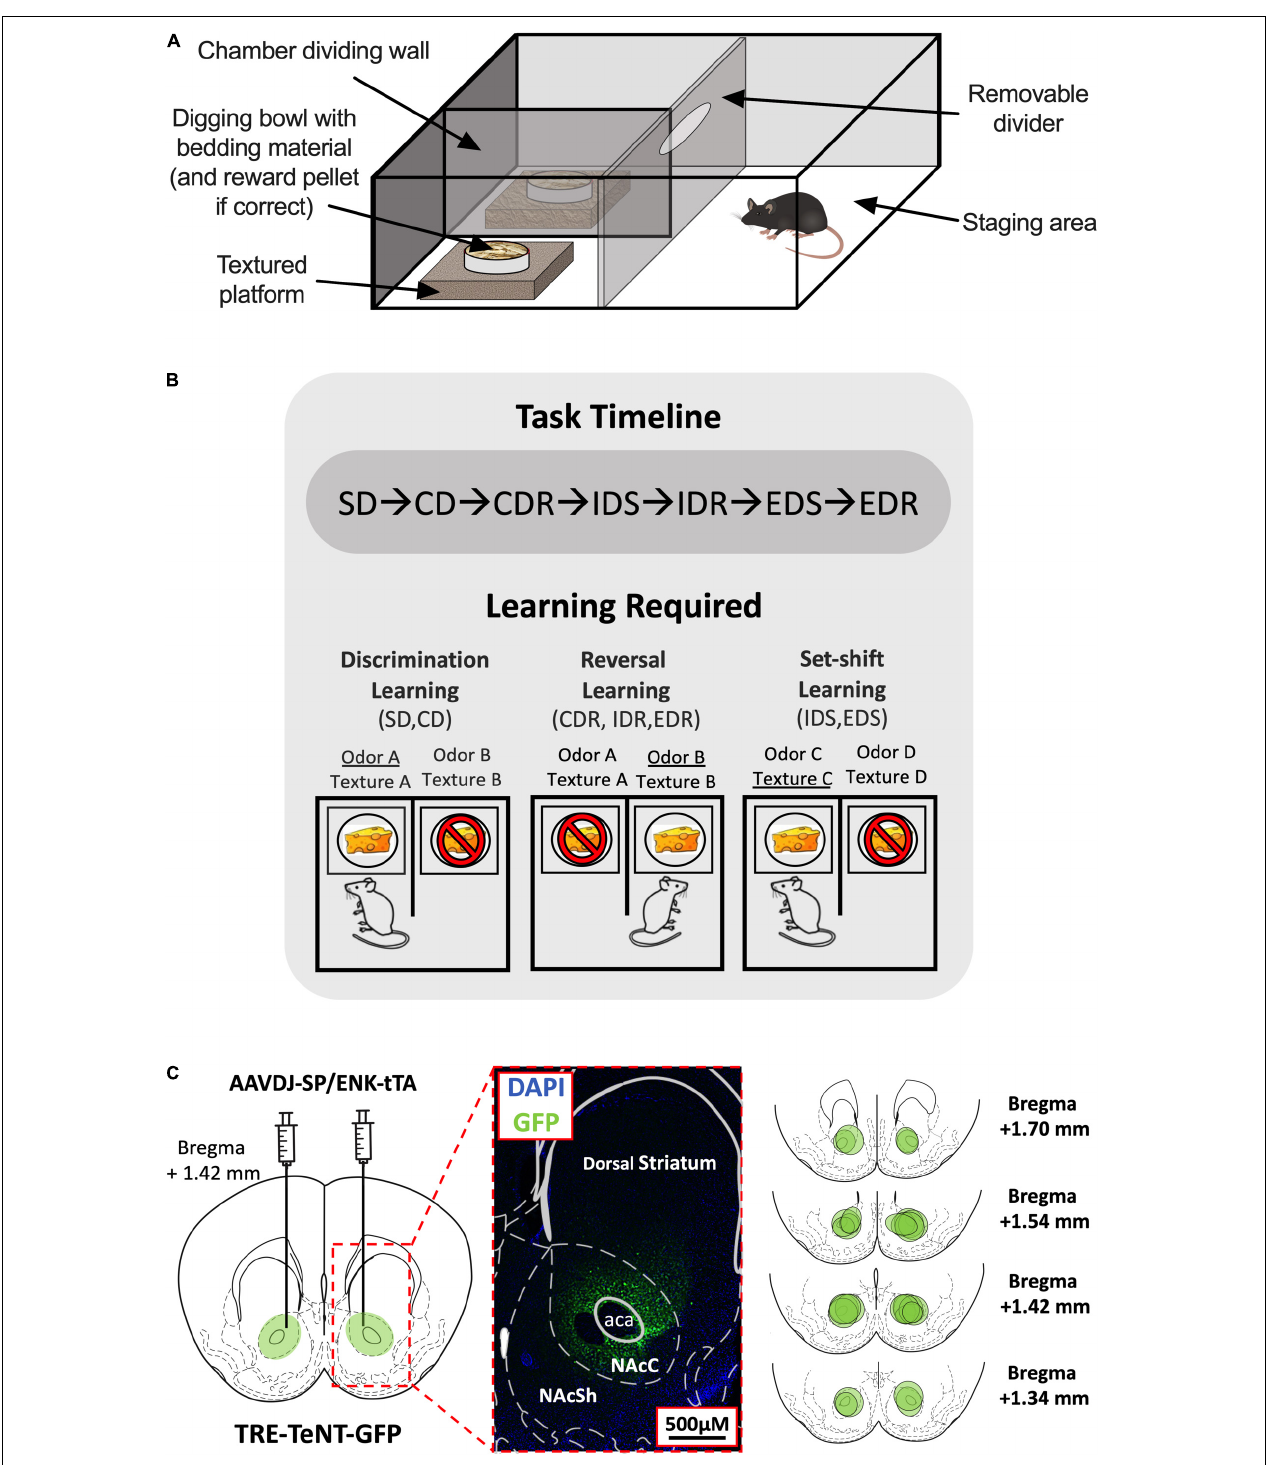
FIGURE 1 | Attentional set-shifting task (ASST) experimental setup. (A) Layout of the ASST apparatus. (B) Timeline of the ASST (top). The three types of learning tested in the ASST and the stages in which they are required (bottom). Examples of correct (indicated by cheese) and incorrect responses (indicated by cheese with a stop sign) and their associated reward-signaling (underlined) and non-reward-signaling (not underlined) cues during each stage type are shown. (C) Virus injection site (left) and magnified histological example of TeNT-GFP expression within the NAc Core region indicated by dotted red lines (middle). The virus spread area for each D1-/D2-MSN-Blocked mouse is indicated by separate green circles in the NAc (right). SD, simple discrimination; CD, compound discrimination; CDR, compound discrimination reversal; IDS, intradimensional shift; IDR, intradimensional shift reversal; EDS, extradimensional shift; EDR, extradimensional shift reversal.